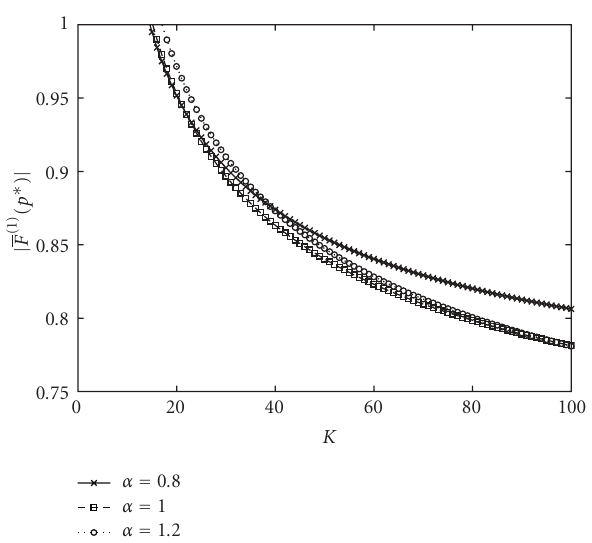
Figure 3: Relationship between K and | F (1) ( p ∗ ) |